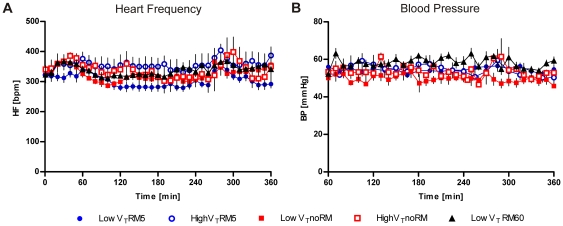
Heart rate and blood pressure.Electrocardiogram (ECG) was recorded permanently. A. Heart frequency (HF) was calculated simultaneously from the ECG and is displayed in beats per minute (bpm). B. Mean arterial blood pressure (BP) was measured via a catheter in the carotid artery.(LowVTRM5 n = 6, highVTRM5 n = 6, lowVTnoRM n = 5, highVTnoRM n = 4, lowVTRM60 n = 5).